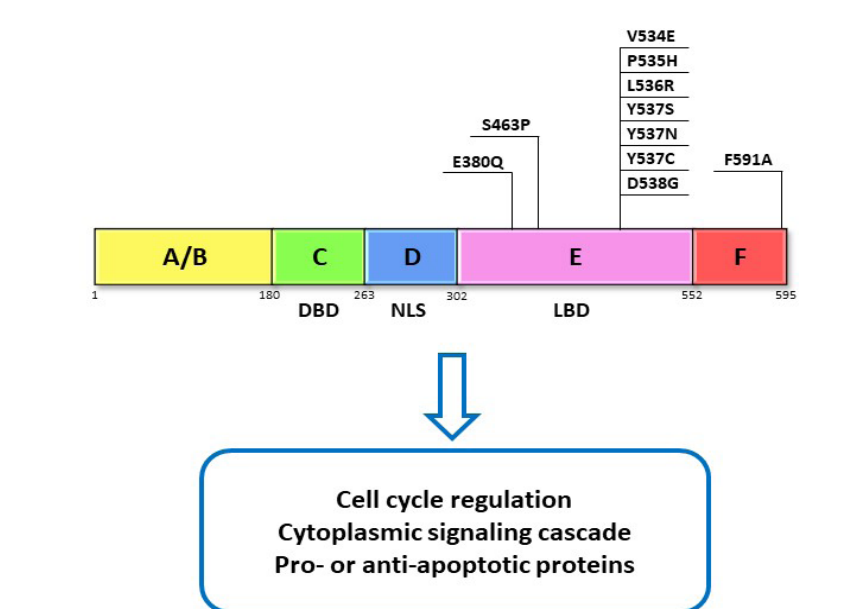
Figure 1. ER domains and function. ERα functional domains and functions are represented as A–F. DBD, NLS, and LBD domain as well as their commonly reported mutations in the LBD. These mutations have been found to contribute to resistance through activation of ERα which is independent of its